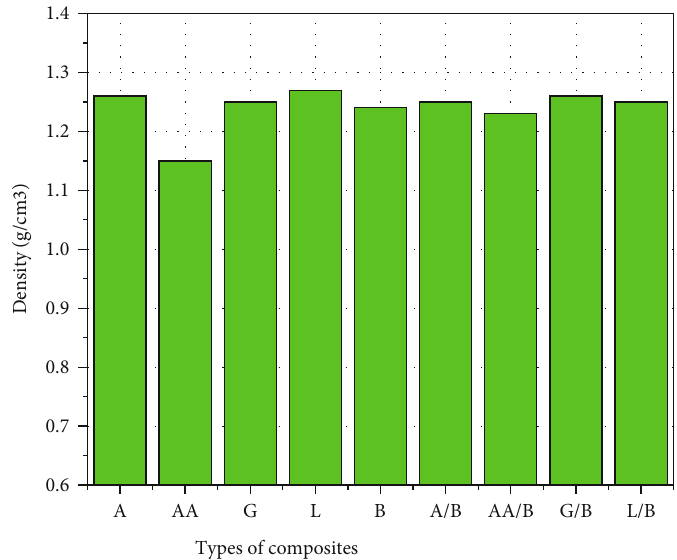
Figure 5: Densities of DPF and hybrid